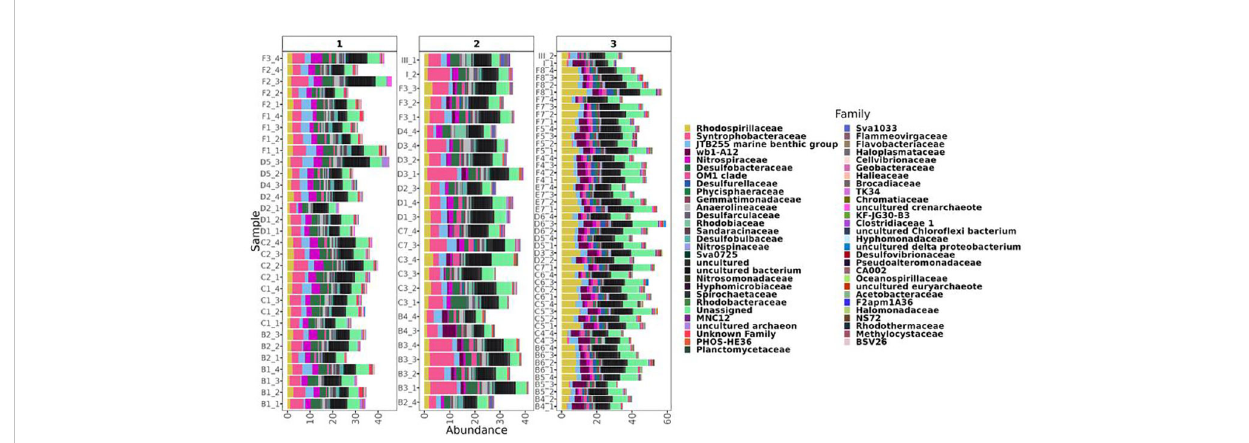
FIGURE 4 Differential abundances analysis. Labels in y axis indicate the sample ID followed by the sampling campaign. Clusters I, II, and III, based on beta diversity analysis, are indicated on